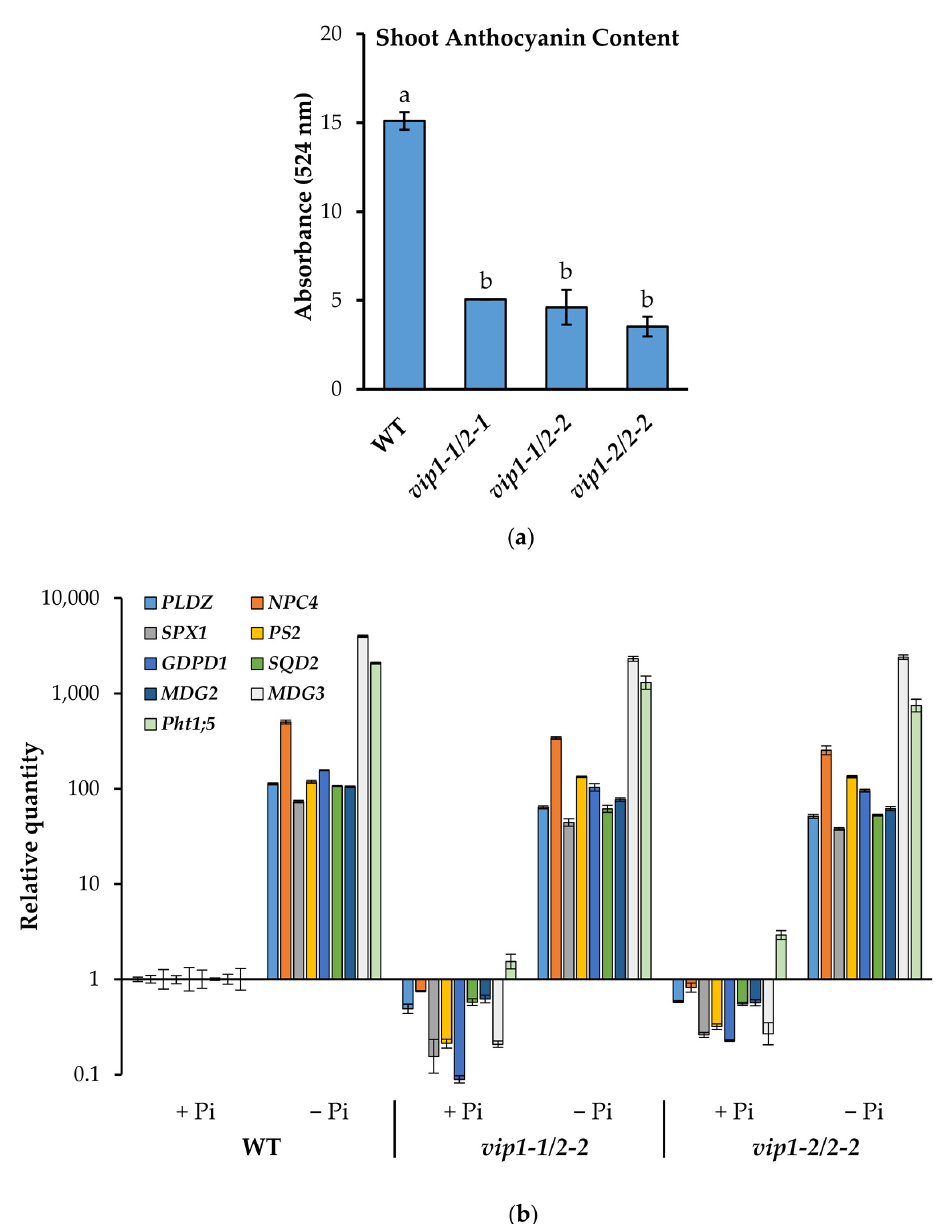
Figure 5. Shoot transcriptional responses to limiting Pi conditions. ( a ) Anthocyanin accumulation in 18-day-old WT and vip double mutant seedlings grown on phosphate-limiting media. Data presented are the average ± SD of two bioreplicate experiments assayed in technical duplicate. Different letters indicate statistically significant means (Tukey HSD, α = 0.05). ( b ) The transcriptional abundance of select PSR genes was queried relative to WT by qRT-PCR using gene-specific primers and PEX4 (which is not transcriptionally responsive to low Pi) as an endogenous control. Data shown are from a representative bioreplicate. Error bars indicate standard